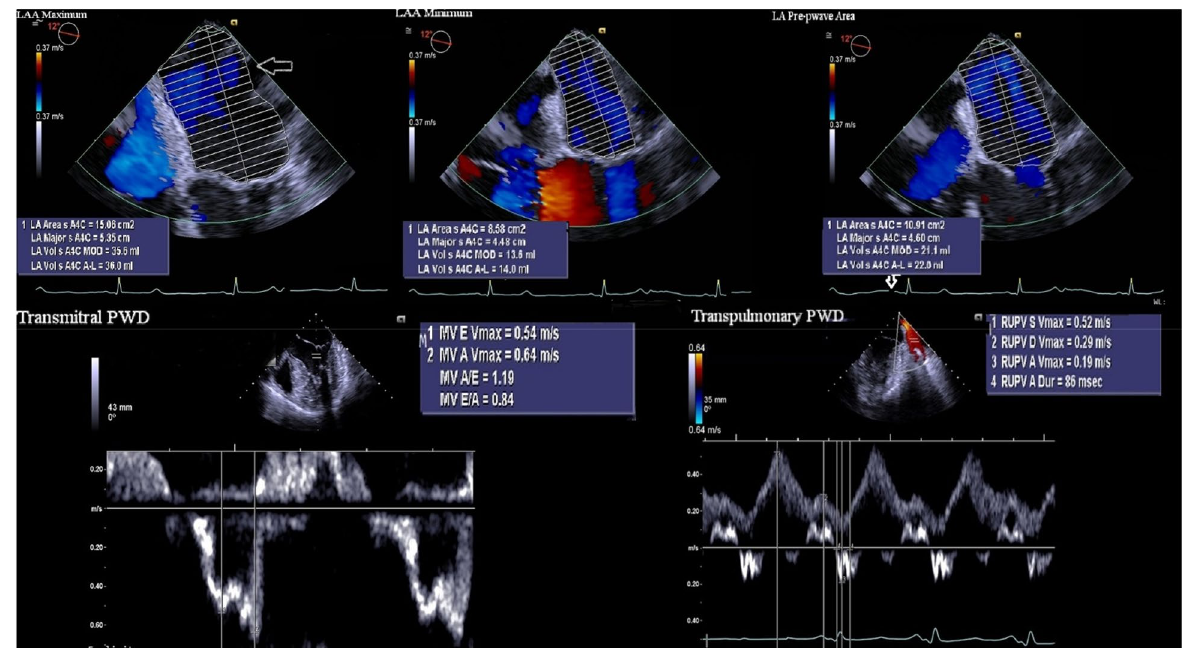
Fig. 6 LA area and PWD parameter evaluations. The uppe row showed maximum (left upper pulmonary vein was not included, labeled by arrow), minimum, and pre P-wave (just before the P wave on the ECG trace, labeled by arrow). LA area and volume evaluation via MOD. The lower row showed transmitral and transpulmonary vein PWD evaluation. All paramaters were measured in the four chamber view. LA, left